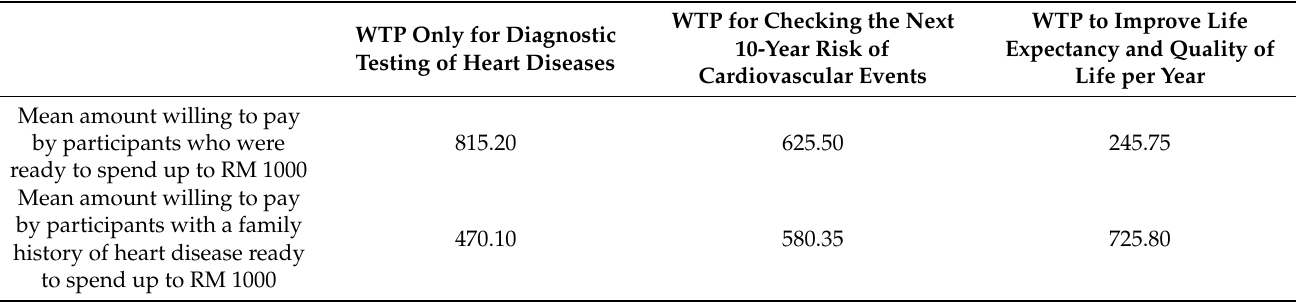
Table 5. Amount in Rinnggit